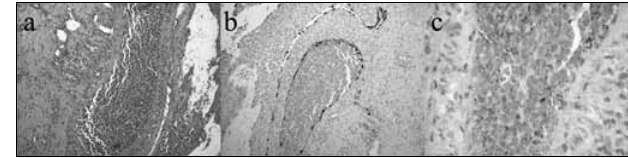
Figure 1. Histology and immunohistochemistry of a surgical specimen (esthesioneuroblastoma). Key: HE-stained histology of a surgical specimen (a) and positive immunohistochemistry for S-100 (b) and synaptophysin (c) markers. Source: own